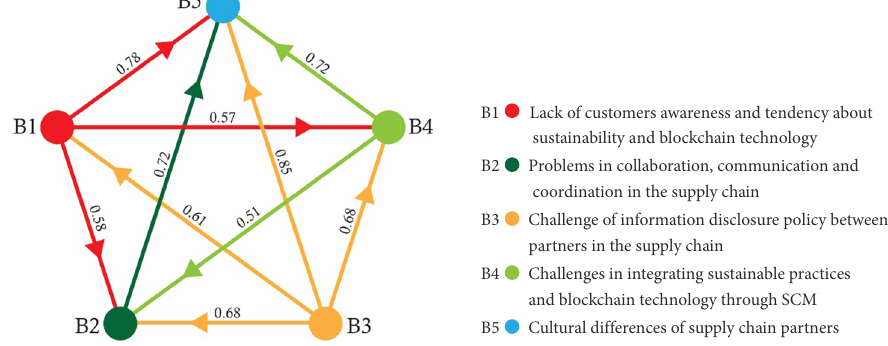
Figure 6. The visualization of the credal ranking for inter-organizational